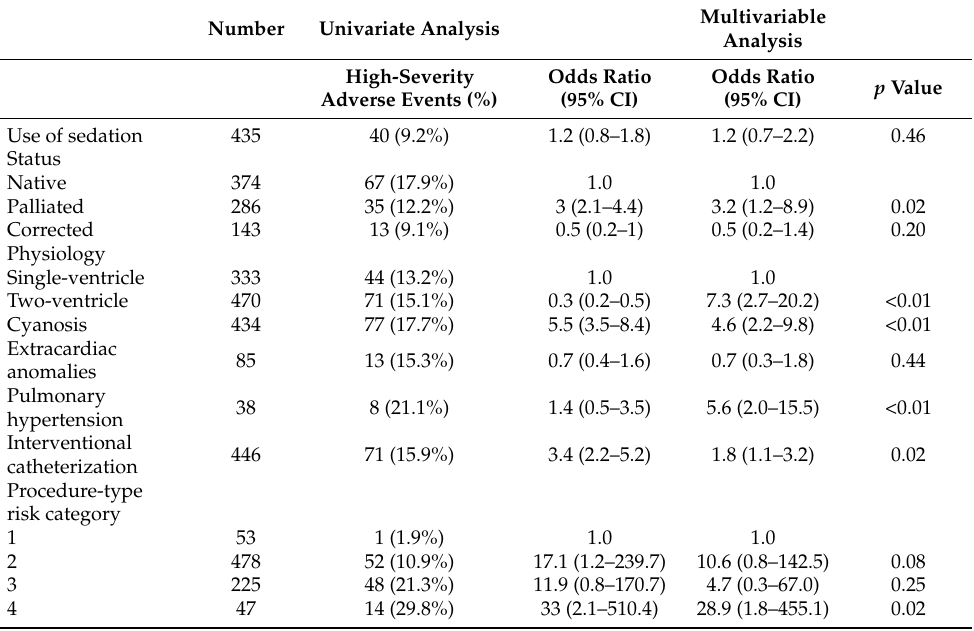
Table 6. Predictors of high-severity adverse events and multivariable